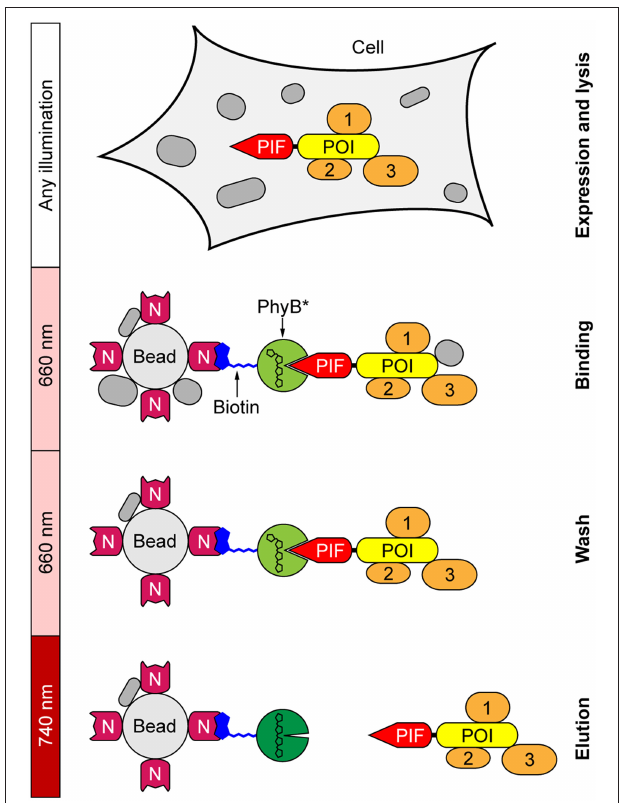
FIGURE 1 | Light-controlled affinity purification of proteins. The protein of interest (POI) is expressed in the desired cells as a fusion protein with a truncated variant of phytochrome interacting factor 6 (PIF) serving as the affinity tag. Biotinylated phytochrome B (PhyB*) is immobilized on NeutrAvidin (N)-functionalized agarose beads. Following cell lysis, the POI is bound via its PIF tag to PhyB* under 660nm light. After washing to remove unspecifically bound proteins under continued 660nm illumination, PIF-POI is eluted in washing buffer from PhyB* beads by switching illumination to 740nm light. Interaction partners (1–3) of the POI are